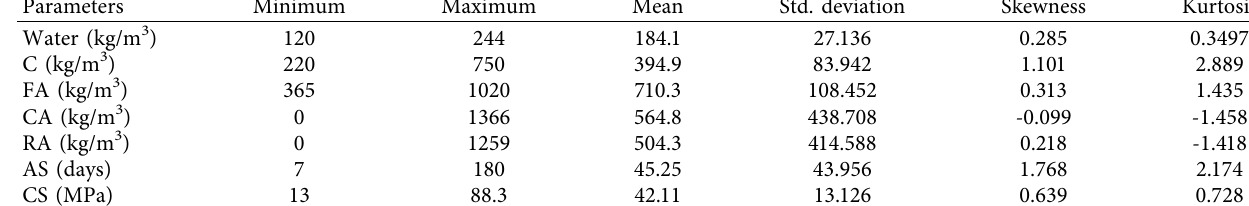
Table 1: Statistical measures of the studied